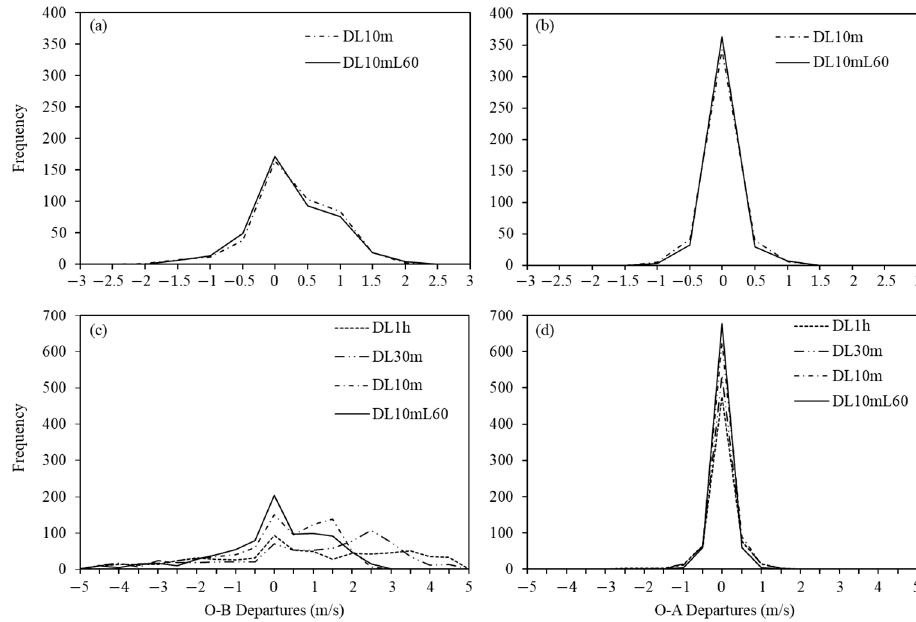
Figure 4. Background ( a , c ) and analysis ( b , d ) departures for lidar radial velocity (Vr) from assimilation experiments at ( a , b ) 07:00 UTC and ( c , d ) 10:00 UTC 15 October 2016.